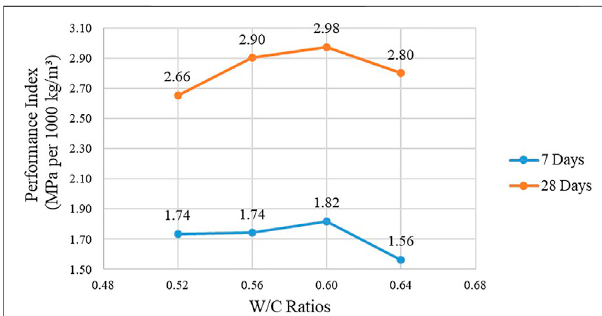
FIGURE 4 | Performance index of LFC-CTW25.